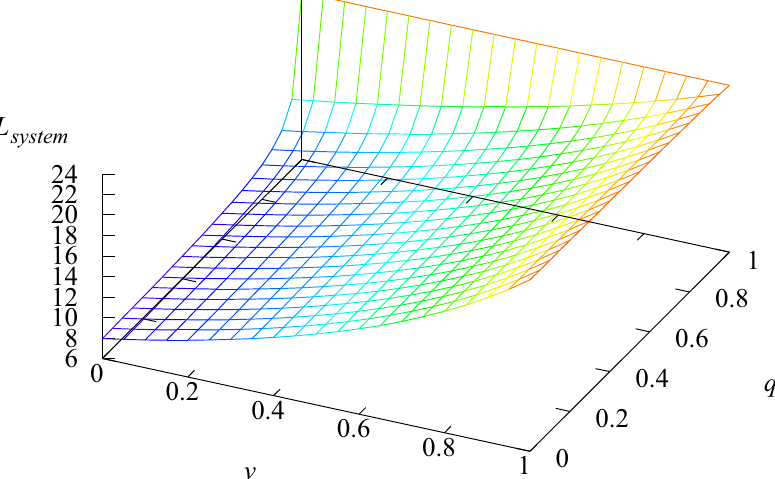
Figure 7. Dependence of the average number of customers in the system L system on the parameters q and ν .